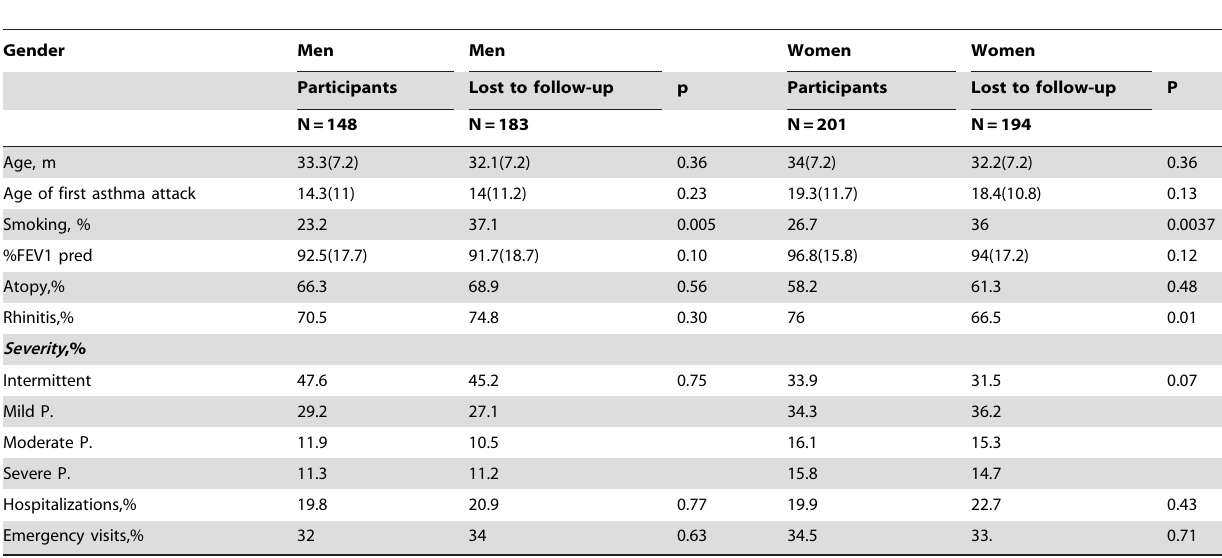
Table 1. Characteristics of subjects who provided respiratory data in the two assessments as compared with those not followed- up at the second survey by gender.